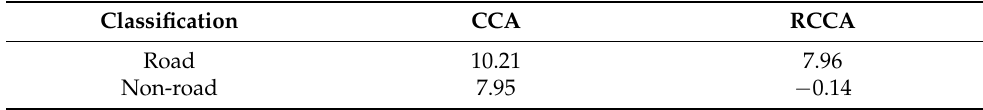
Table 6. The energy comparison of CCA and RCCA sampling.